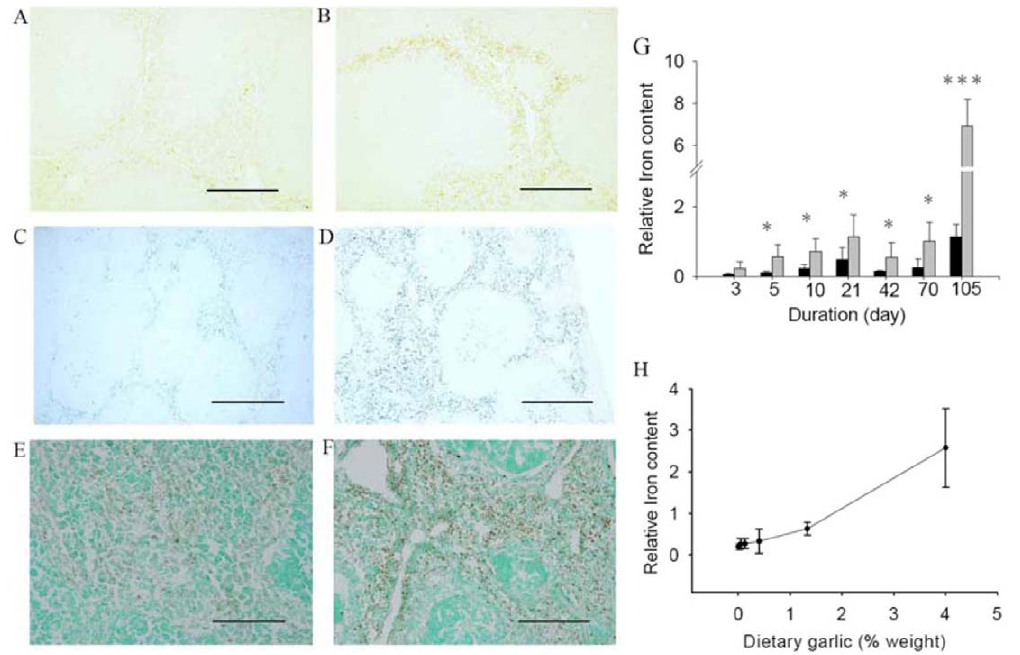
Figure 2. Histochemical phenotypes of spleens of C57BL/6J (n=6) mice on cellulose-(A, C, E) and garlic-supplemented (B, D, F) diets (week 15). Spleen sections were shown with no staining (A, B) to reveal bilirubin, with Prussian blue stain for Fe 2 + (C, D), and with Gomori stain for macrophages via acid phosphatase and counter-stained for nuclei with methyl green (E, F). (G) Time course (n=4) of Fe 2 + accumulation in the spleens due to dietary garlic (4%). (H) Dose-response (n=6) of dietary garlic in spleen sections. Scale bars represent 200 m m (A–F). (Statistics: *, p , 0.05; ***, p , 0.005, student’s t test). Black bars: control; gray bars: garlic diet.